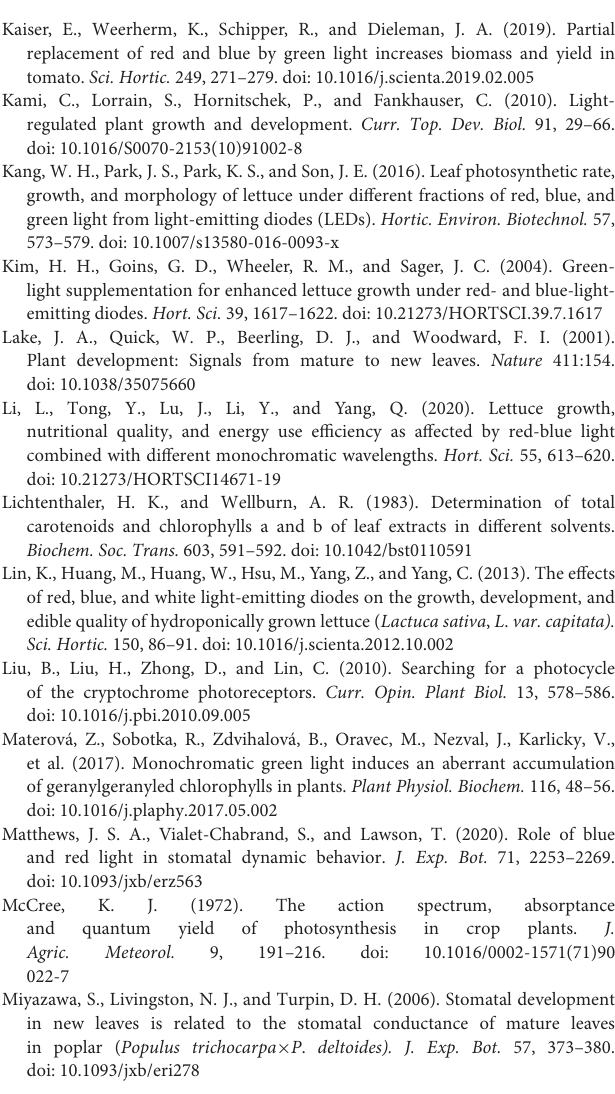
Supplementary Figure 1 | The diagram of the measuring